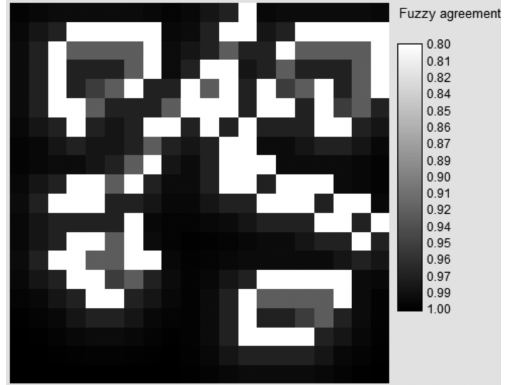
Fig. 4: Fuzzy agreement map for the two synthetic maps compared